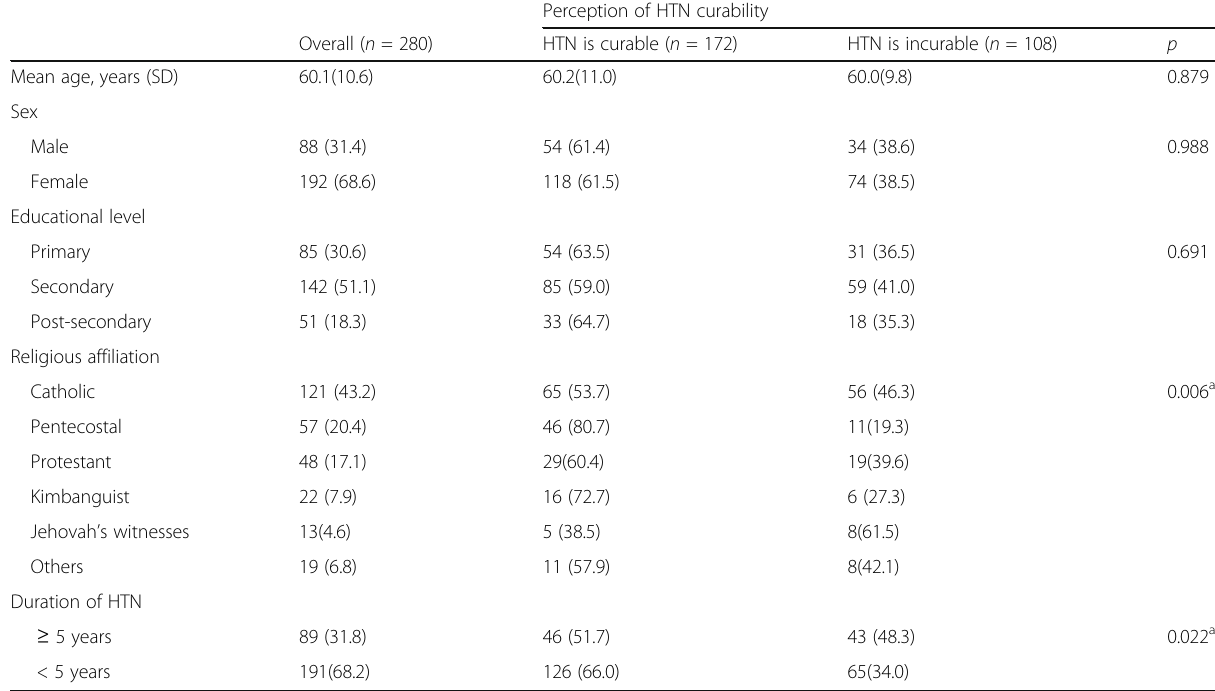
Table 9 The perception of HTN curability and patient ’ s